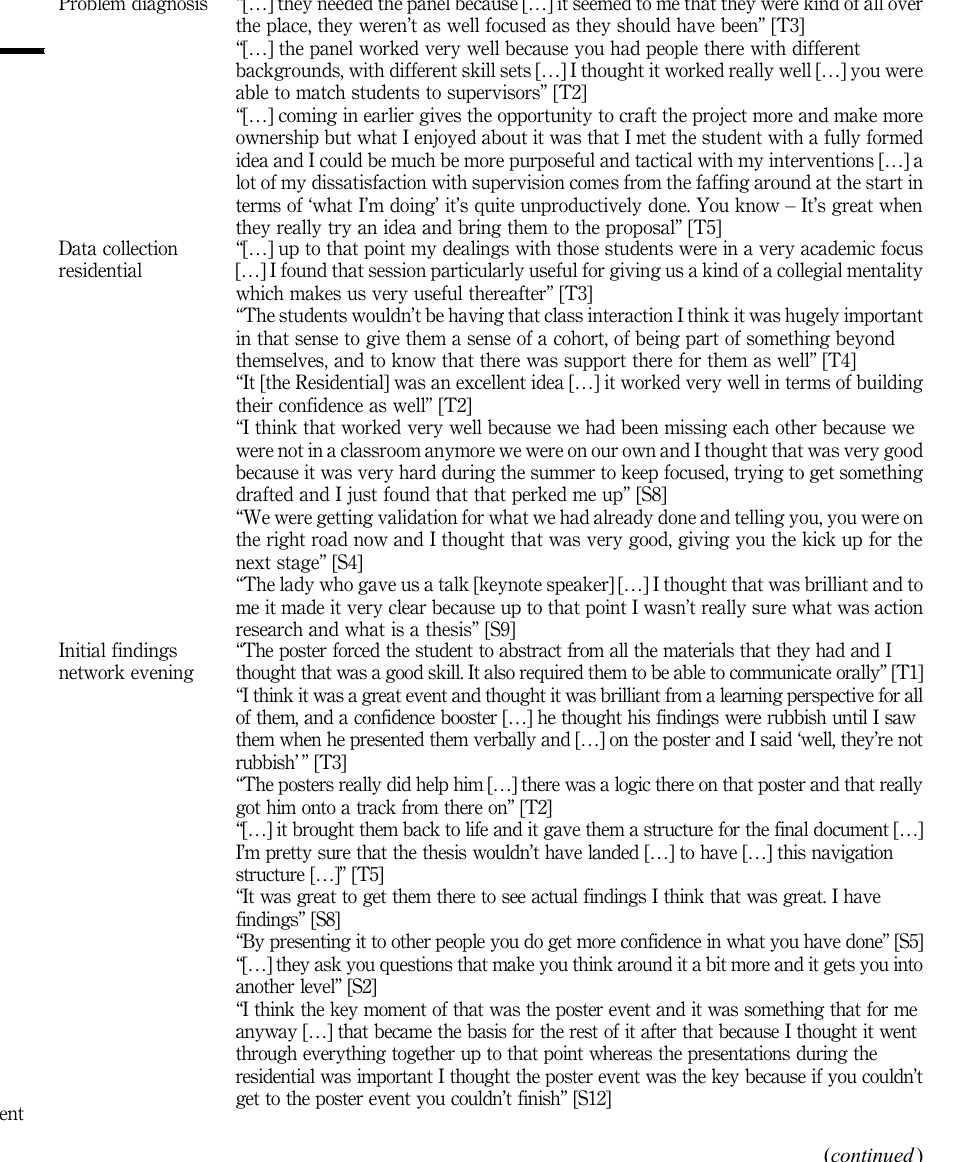
Table AI. Program component focus group